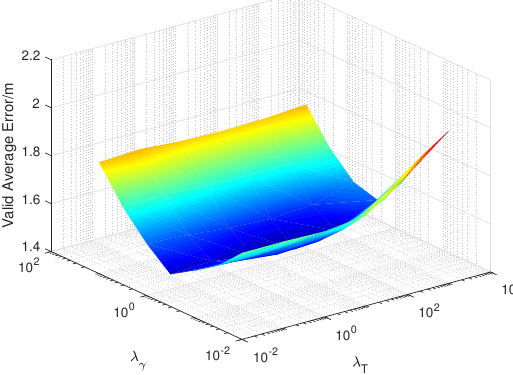
Figure 13. Validation error when taking different super-parameters in the 12th month (M.